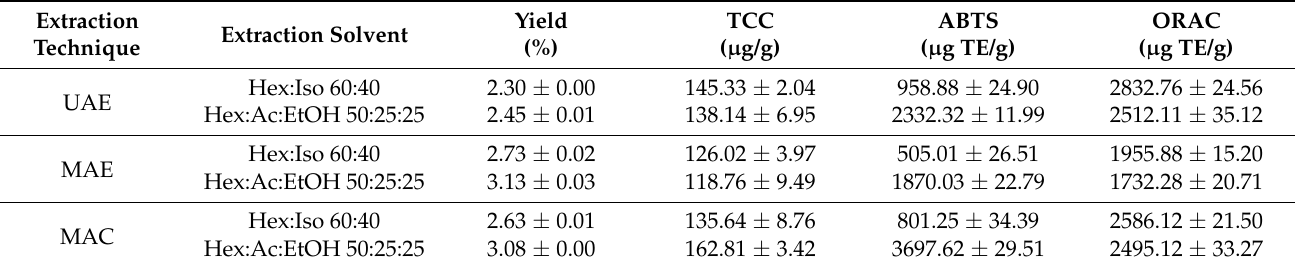
Table 1. Yield (%) of extraction, TCC and in vitro antioxidant activities (ABTS and ORAC assays) of